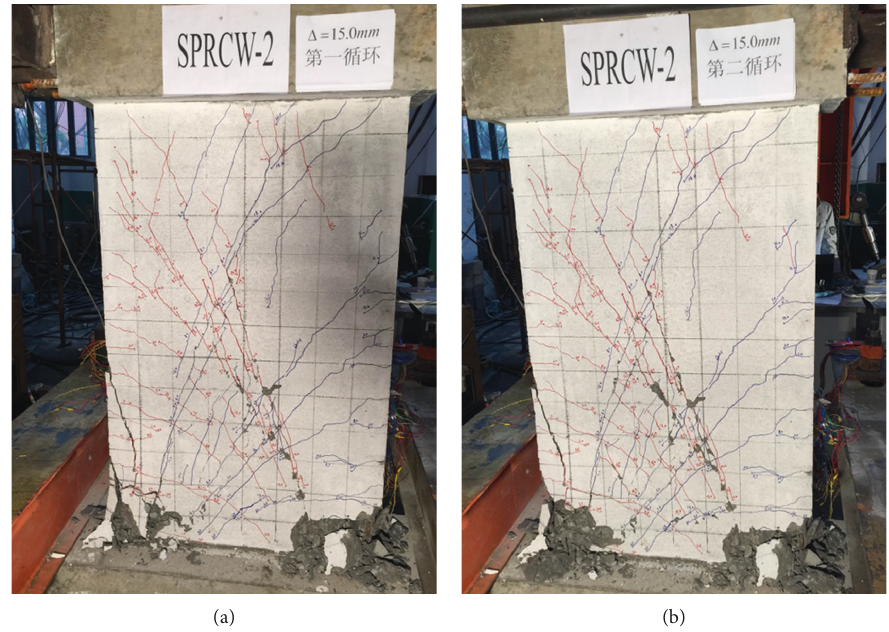
Figure 13: Diagram of cracks in the cycle with Δ � 15mm. (a) First cycle. (b) Second